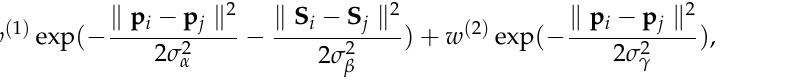
Figure 7. Comparison of the short-range CRF and the fully connected CRF models. ( a ) In the short- range CRF, only the 4 nearest neighbors are connected to a certain node; ( b ) in the fully connected CRF, every two nodes are connected by an edge (from [59]).